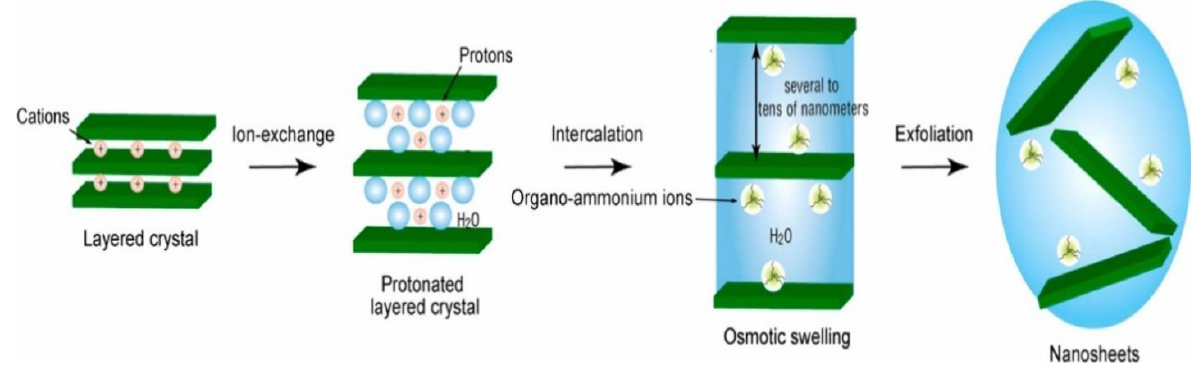
Figure 4. Schematic illustration of the common soft chemical exfoliation approach for synthesizing metal oxide nanosheets. Reprinted with permission from [49]. Copyright 2018 Elsevier.